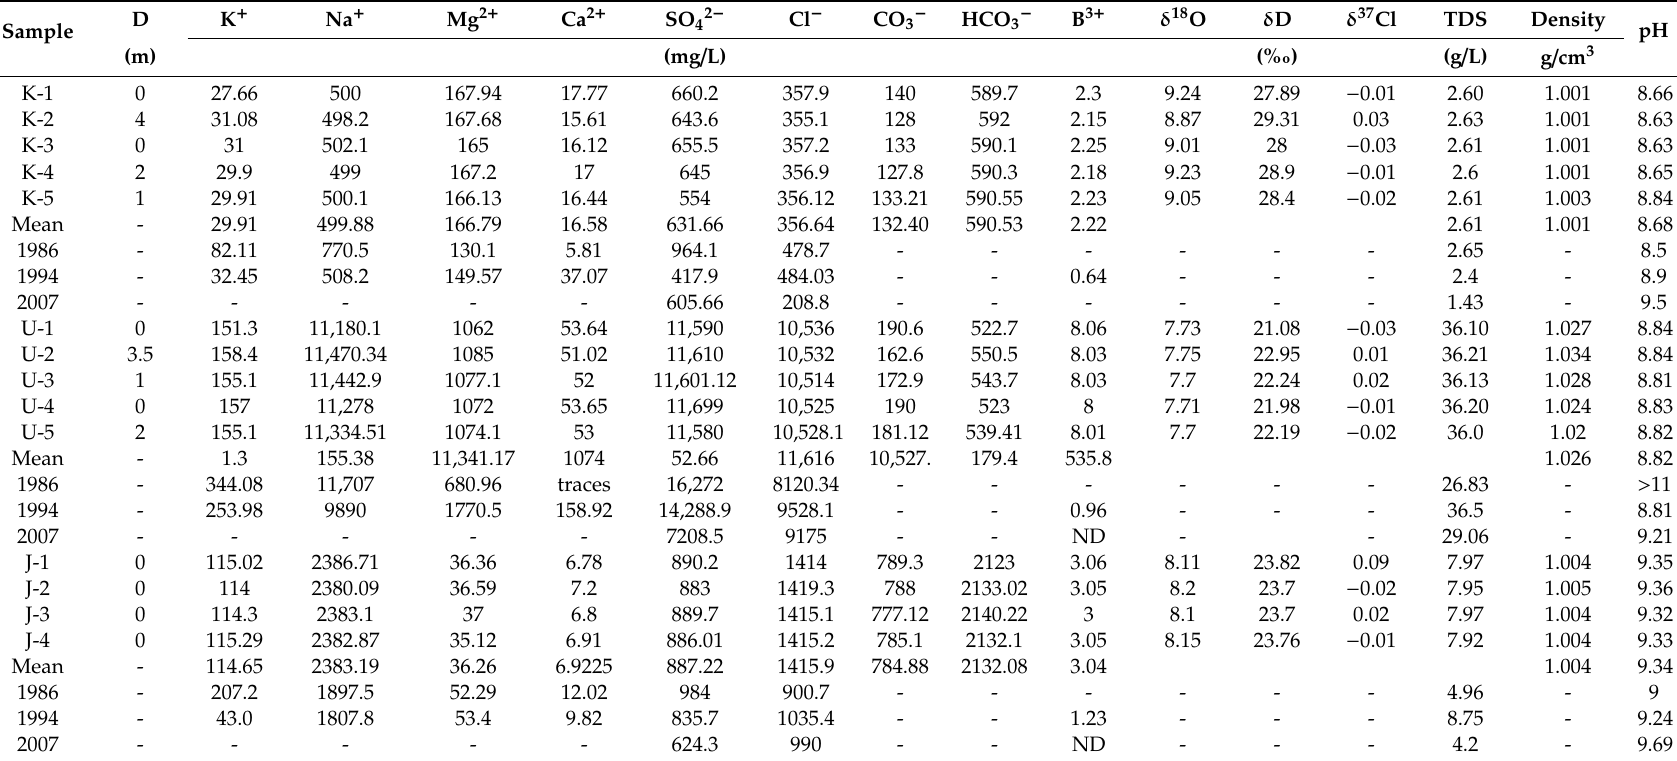
Table 1. Ion compositions, water ( δ D, δ 18 O) and chlorine ( δ 37 Cl) stable isotope compositions of the saline lakes of the Soan-Sakaser Valley (Salt Range, Pakistan) and their comparison with previous studies. Data sources: 1986 [40], 1994 [39] and 2007 from